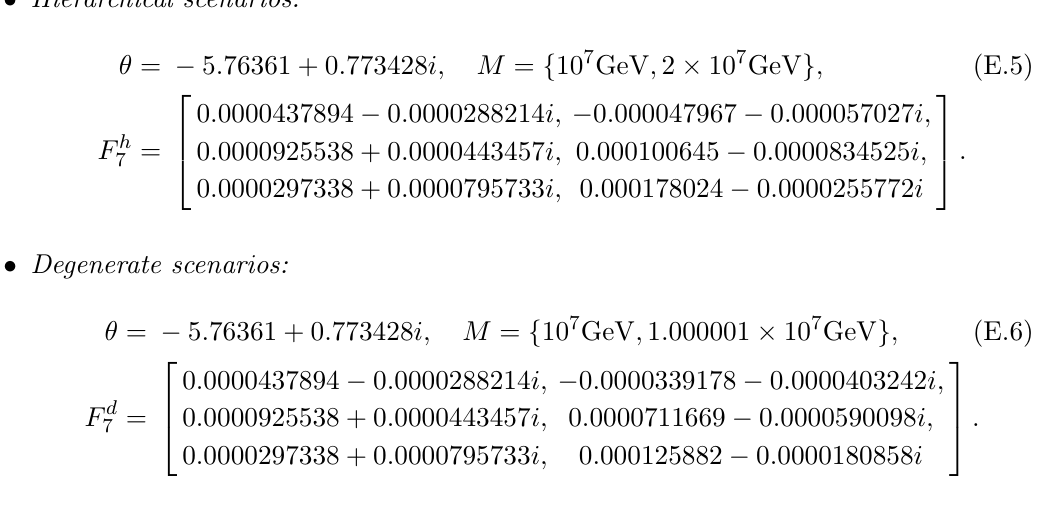
the left plot uses the Yukawa matrix of eq. (E.6), while the right plot uses eq.